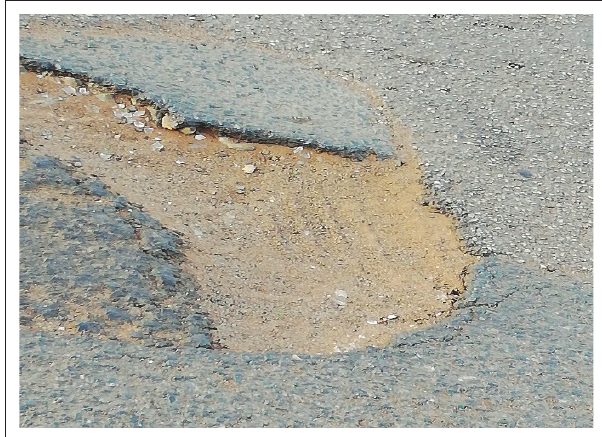
FIGURE 1: Potholes in Extensions 12 in Protea Glen.